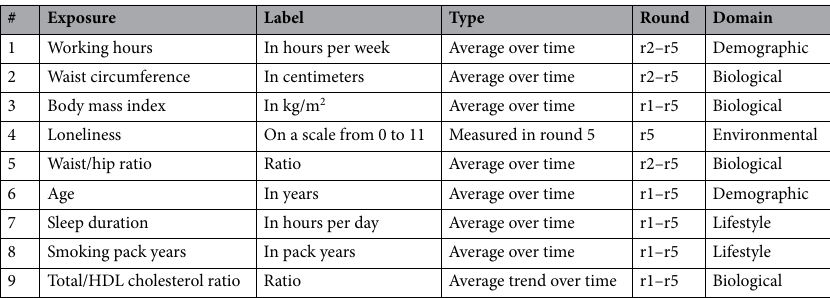
Table 4. Top 9 predictors of self-perceived